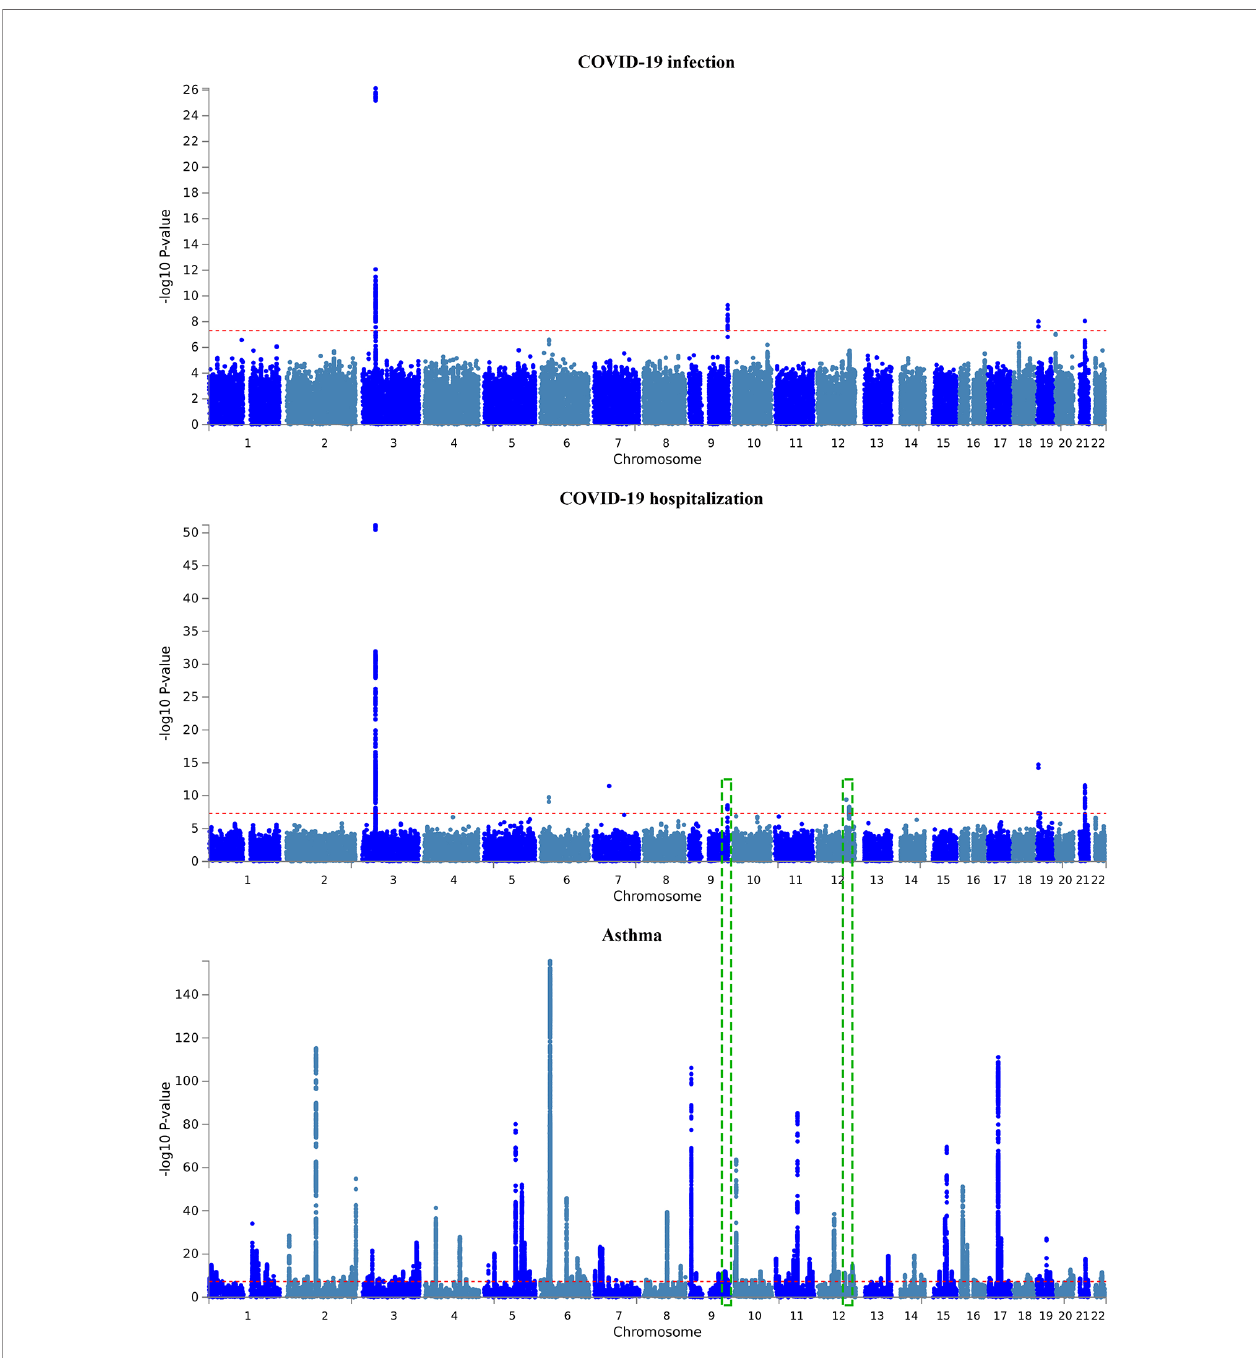
FIGURE 2 | Manhattan plot of GWAS results of the COVID-19 outcomes and asthma. The x-axis is chromosomal position of SNPs and the y-axis is the signi fi cance of the SNPs (-log 10 P). Each horizontal dashed line denotes genome-wide signi fi cance level of 5E-8. Dashed green rectangles indicate the two overlapped genomic loci between COVID-19 hospitalization and